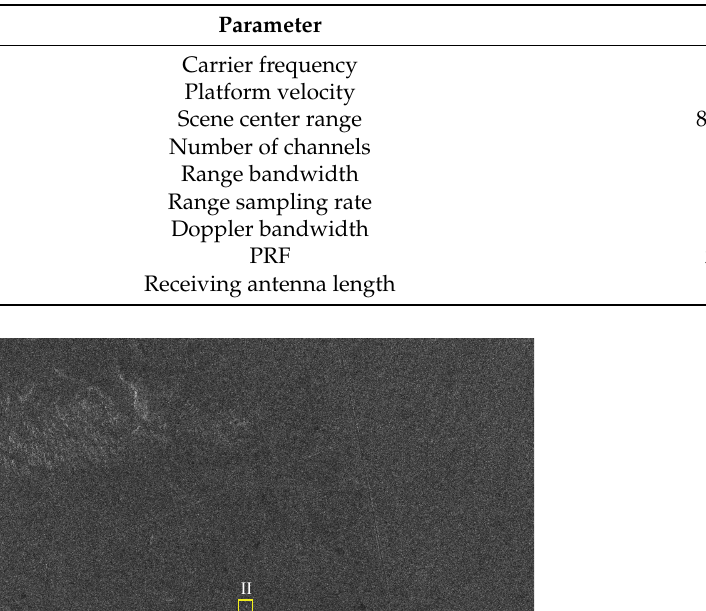
Table 3. Main parameters of the simulated HRWS SAR system.